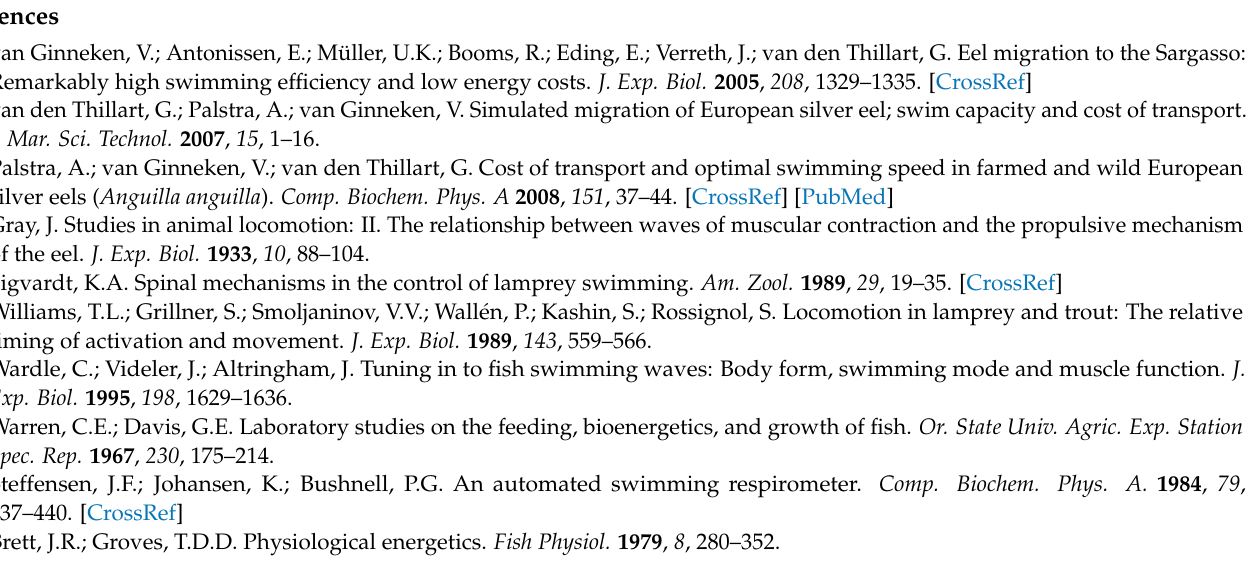
section for three speeds. Figure S4: Recovery rate of the fish after handling. Figure S5: Divergence in the velocity vector fields and cumulative probability distribution of the normalized